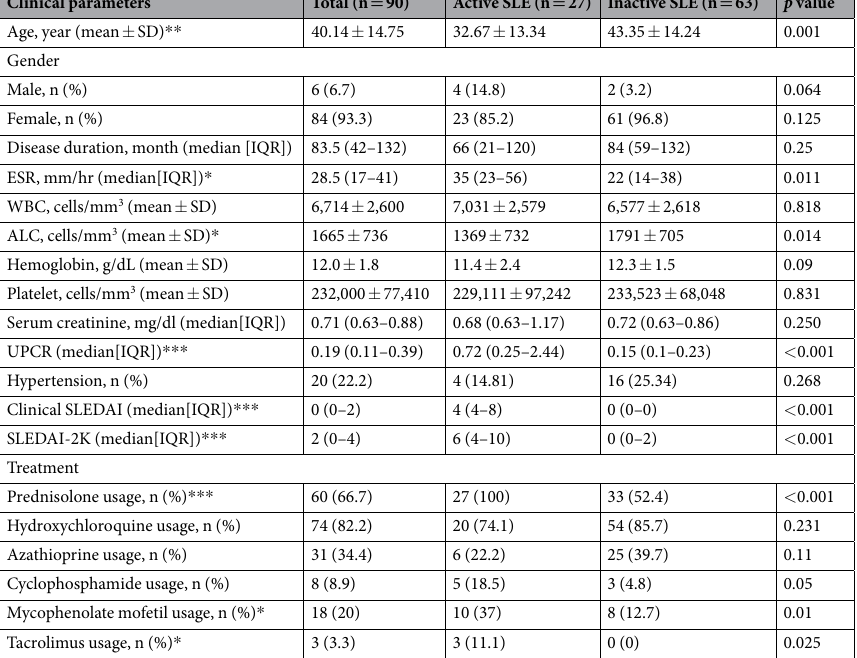
Table 1. Patient demographics and clinical characteristics. ESR, erythrocyte sedimentation rate; ALC, absolute lymphocyte count; UPCR, urine protein to creatinine ratio; SLEDAI, Systemic lupus erythematosus disease